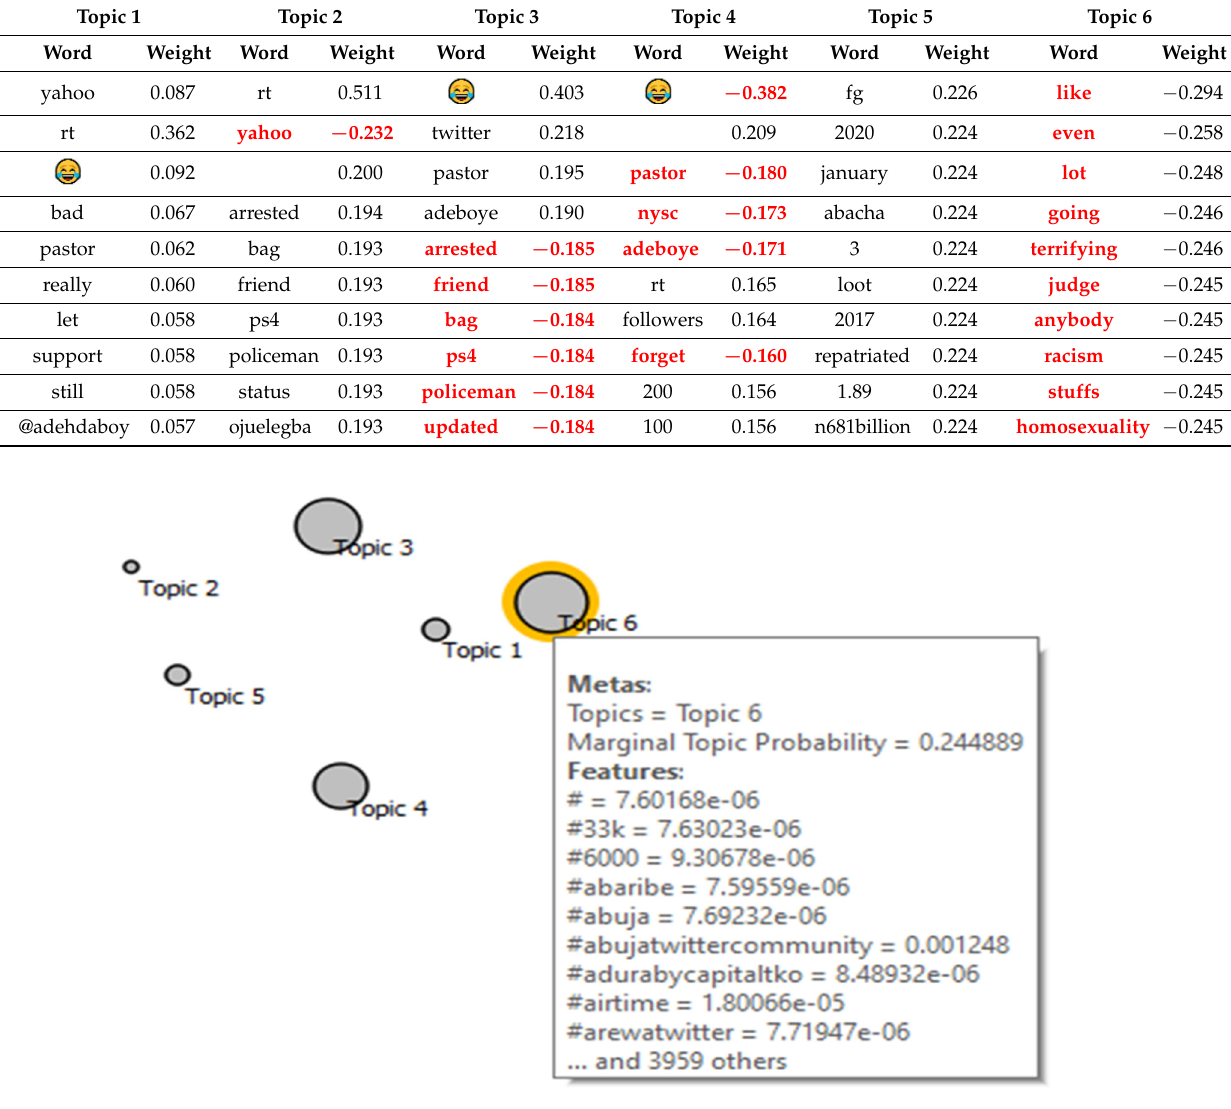
Figure 10. Visualizing LDA topics using MTP with multidimensional scaling points. We further used the box plots to visualize the words that are most representative of each topic. The box plot sorts the variables (words) by separating the selected subgroup values. The subgroup ‘yes’ represents the weights of the most representative words of the topic selected on the MDS graph. Table 7 shows the top ten most representative words for LDA topics 1–6 selected on the MDS graph and visualized on the box plot. The words are sorted by their order of relevance to the topics. Table 7. Top ten words by order of relevance to the topic in the corpus extracted from the box plot.